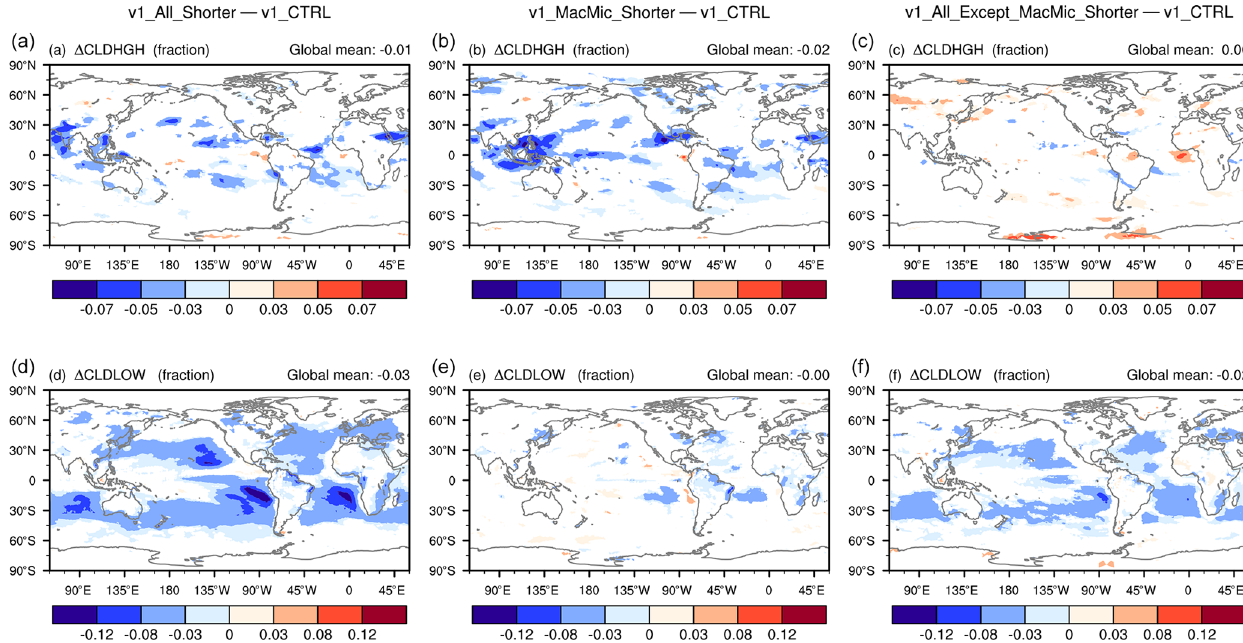
Figure 9. Geographical distribution of 10-year mean differences in high-cloud fraction (CLDHGH, a, b, c ) and low-cloud fraction (CLD- LOW, d, e, f ). (a, d) Differences between v1_All_Shorter and v1_CTRL, revealing the impact of shortening all major time steps listed in Eqs. (1)–(4). (b, e) Differences between v1_MacMic_Shorter and v1_CTRL, revealing the impact of shortening time steps for the subcy- cled cloud macrophysics and microphysics parameterizations. (c, f) Differences between v1_All_Except_MacMic_Shorter and v1_CTRL, revealing the impact of shortening step sizes outside the cloud macrophysics and microphysics subcycles. Statistically insignificant results are masked out in white. The simulation setups are summarized in Tables 1 and A1. Schematics depicting the time integration loop and different step sizes can be found in Figs. 2 and